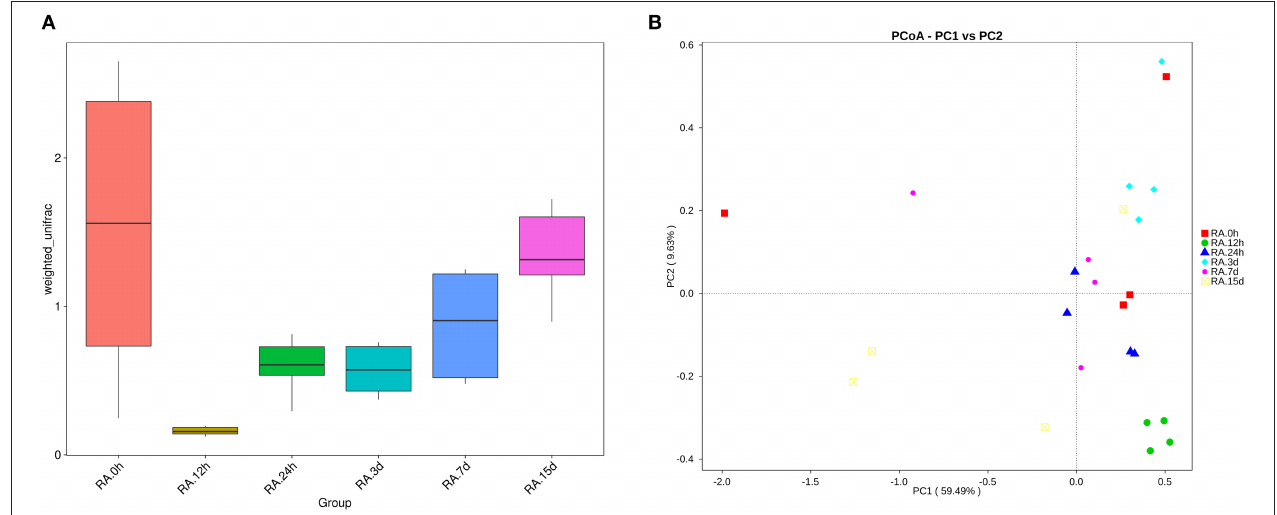
FIGURE 3 | YM001 alters the diversity of intestinal flora of tilapia at different observing times. (A) A box chart based on Weighted Unifrac Beta diversity. (B) Principle coordinate analysis (PCoA) Based on Weighted Unifrac distance. The samples at 0h, 12h, 24h, 3 d, 7d, 15d were represented as color icons with red square, green dot, blue triangle, turquoise square, pink dot, orange